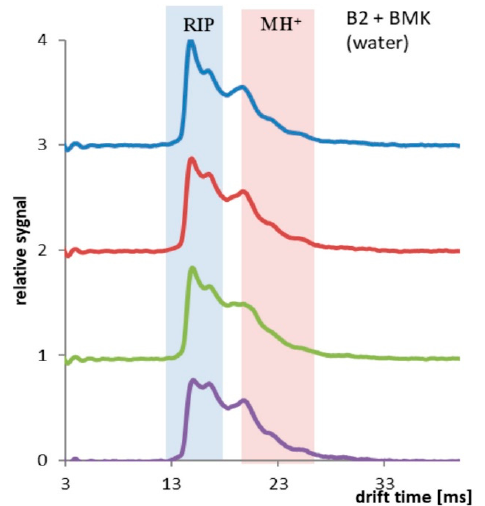
Figure 8. PP tubing coated two times with PSi, spectra collected every 10 min, total time 30 min. When PP tubing coated three times with PSi was immersed in the BMK water solution, a change in both RIP and MH + signals was observed. Only after 1 min of the experiment, the decay in the RIP signal and raise in the sample signal at the drift time of 23 ms was observed (Figure 9). After 4 min of the experiment, PP/PSi tubing was saturated with the BMK.